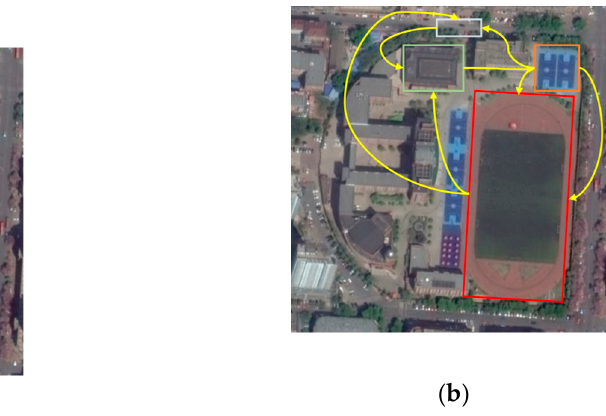
Figure 1. ( a ) Local visual feature and ( b ) long-term contextual feature are selected from the “School” category. The long-range contextual information is not considered by CNNs, which specialize at extracting local characteristics. ( a , b ) show many distinct land covers, such as “Playground,” “Building,” “Road,” and “Basketball Court.” If the model only concentrates on those local regions, the “School” scene could be mistaken for other scenes with comparable ground objects. Thus, to accurately classify this scene as “School,” local regions and their long-term contextual dependencies, as indicated by the yellow arrows, should be taken into account by the expected model.